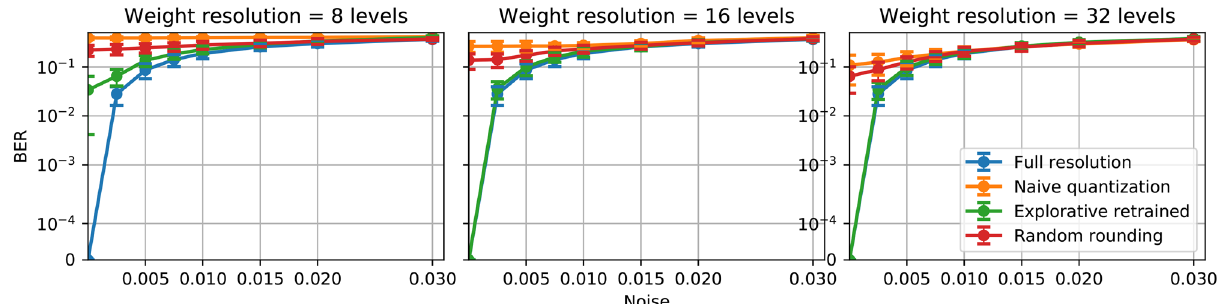
Figure 5. Performance comparison of three different weighting resolutions, 8 levels (left), 16 levels (middle), 32 levels (right) for the 4-bit delayed XOR task vs different noise levels. The blue curve represents the performance of full-resolution weights; the orange curve represents ‘naive’ quantization weights; the green curve for explorative retrained quantization